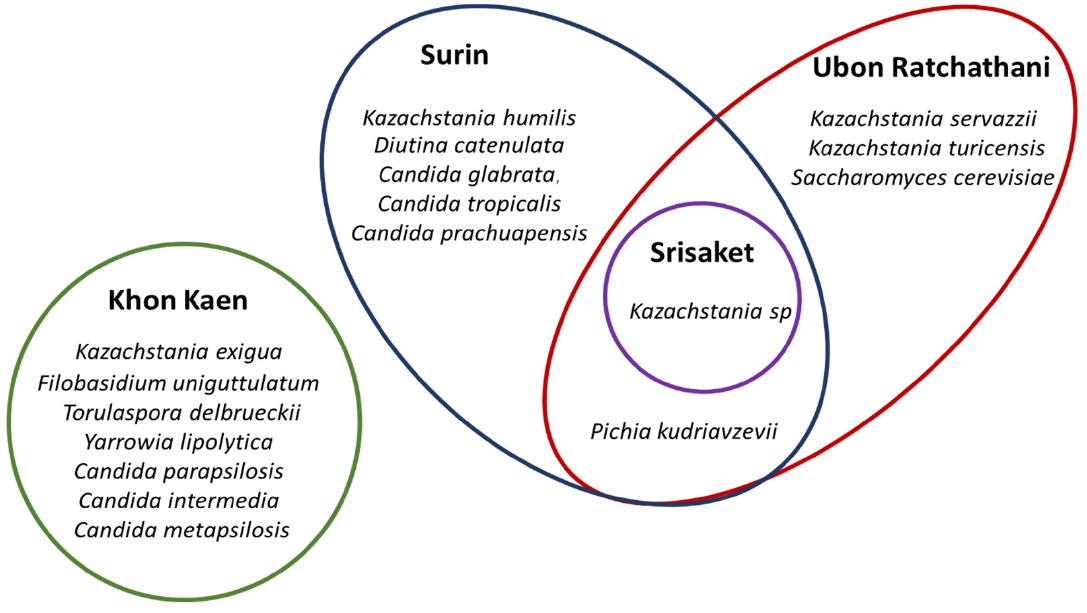
Figure 6. Distribution of the yeast genera in overall Plaa-som samples collected from 4 different fresh markets in Thailand (Venn diagram).